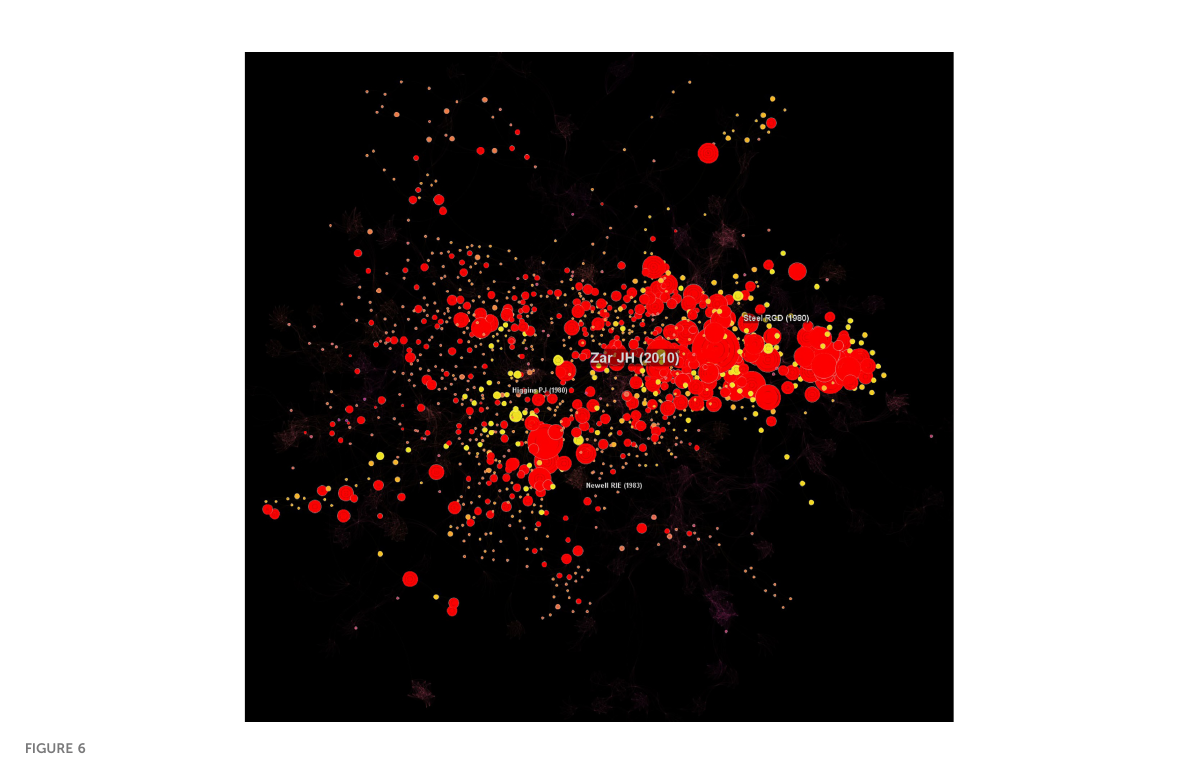
FIGURE 6 Document co-citation